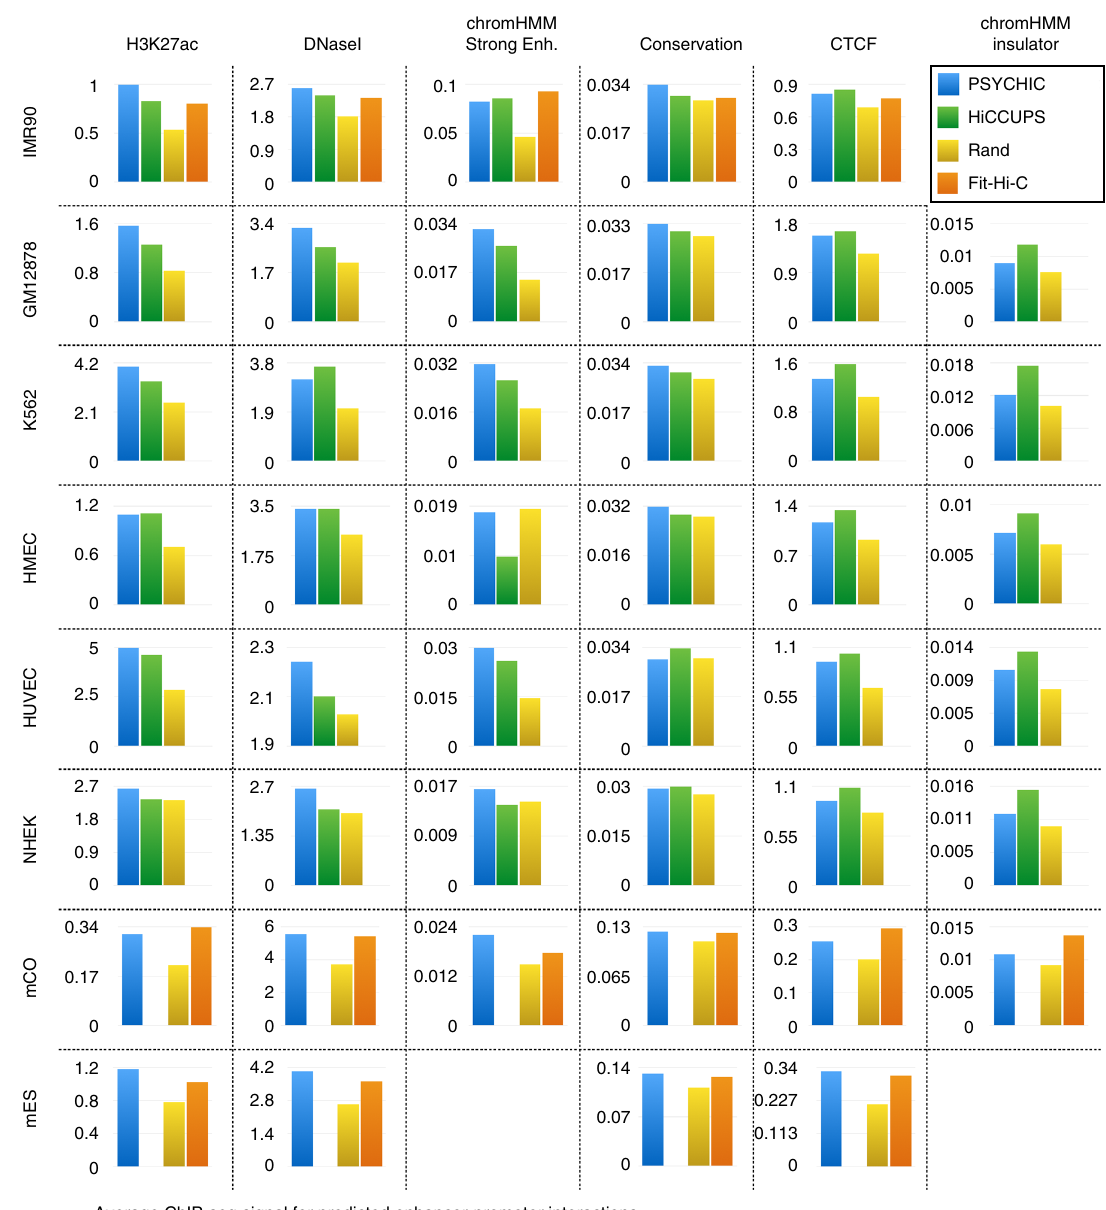
Fig. 5 Promoter – enhancer predictions are supported by ChIP-seq data, DNA accessibility, evolutionary conservation, and chromHMM “ Strong Enhancer ” loci. Shown are the average signal for ChIP-seq and additional genomic data, over predicted enhancer regions using PSYCHIC (FDR < 1e-2, blue), HiCCUPS (green), Fit-Hi-C ( q value < 1e-10 for IMR90 and hES, q < 1e-4 for mCO, orange) or random interactions (yellow). Notably, PSYCHIC predictions are generally more enriched for all enhancer-related data, while HiCCUPS and Fit-Hi-C predictions are more enriched for CTCF and Insulator marks. No chromHMM data was found for line with the relative enrichment of CTCF ChIP-seq signal among standard deviation (15% > 2 SD). Similar numbers are obtained HiCCUPS predictions (Fig. 5).